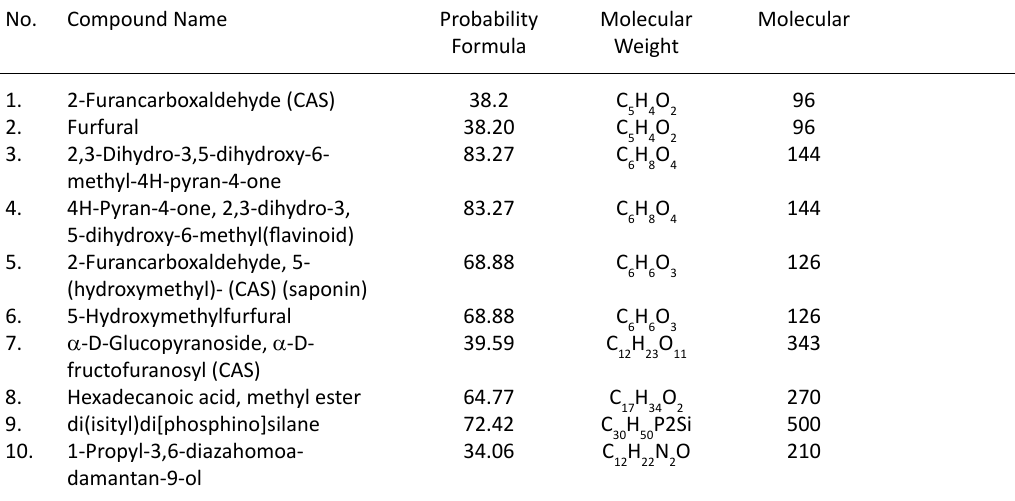
Table 2. Phytochemicals observed with more than 25% probability by GC-MS analysis No.